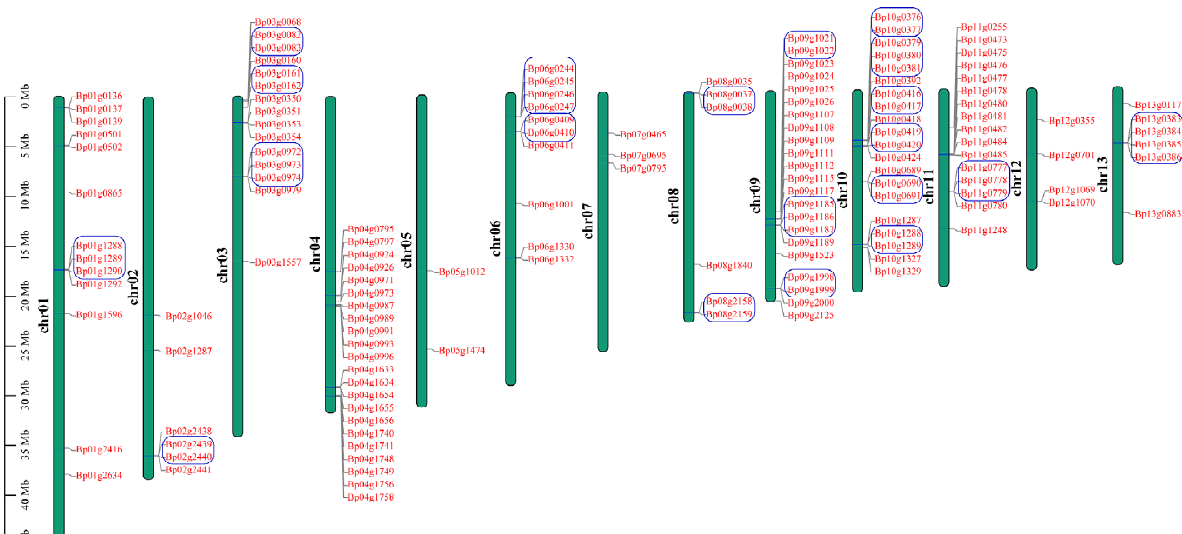
Figure 2. Chromosomal distribution and the tandem duplication of paper mulberry BpUGT genes. Green bars represent the chromosomes. Chromosome numbers are shown at the left of the bar. BpUGT genes are labeled at the right of the chromosomes. The tandem duplicated genes are represented by a blue borderline. The scale bar on the left indicates the chromosome lengths (Mb).